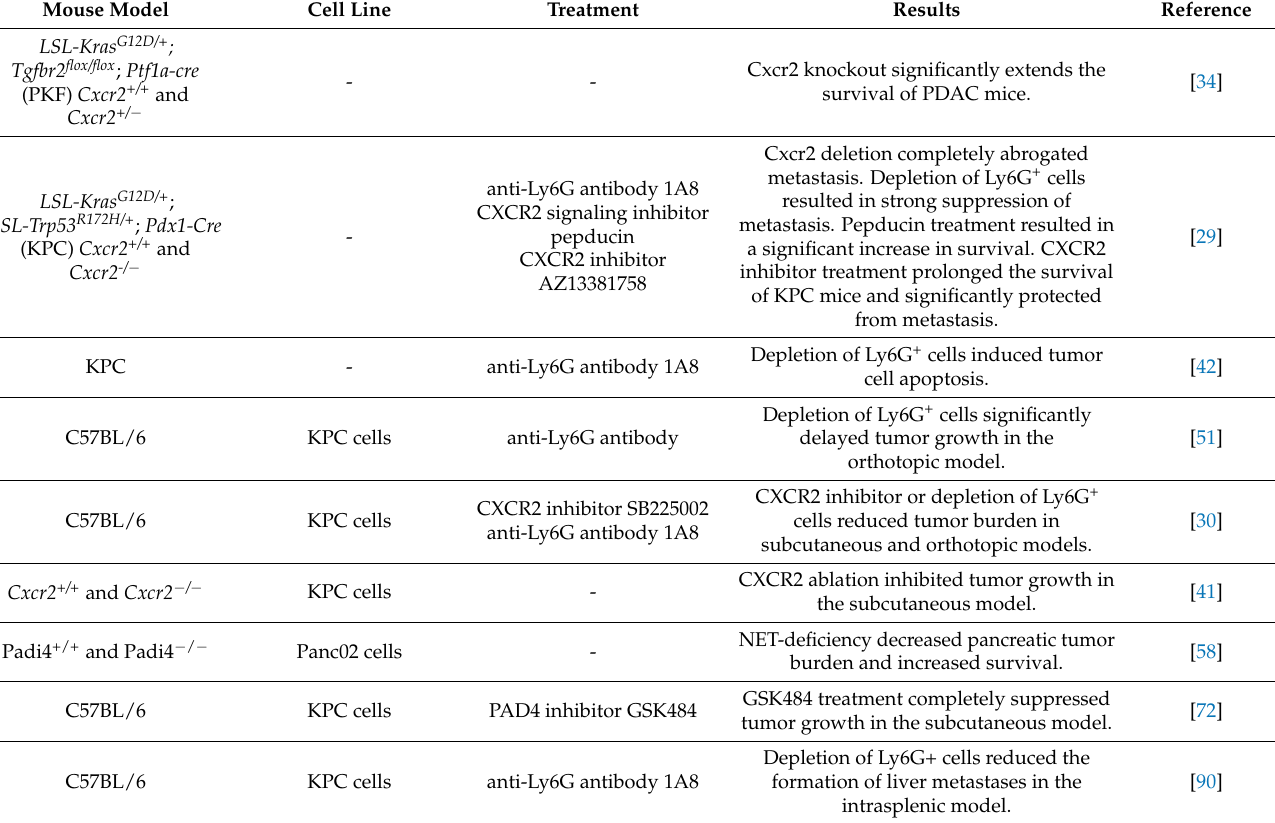
Table 1. Preclinical studies of targeting neutrophils in pancreatic